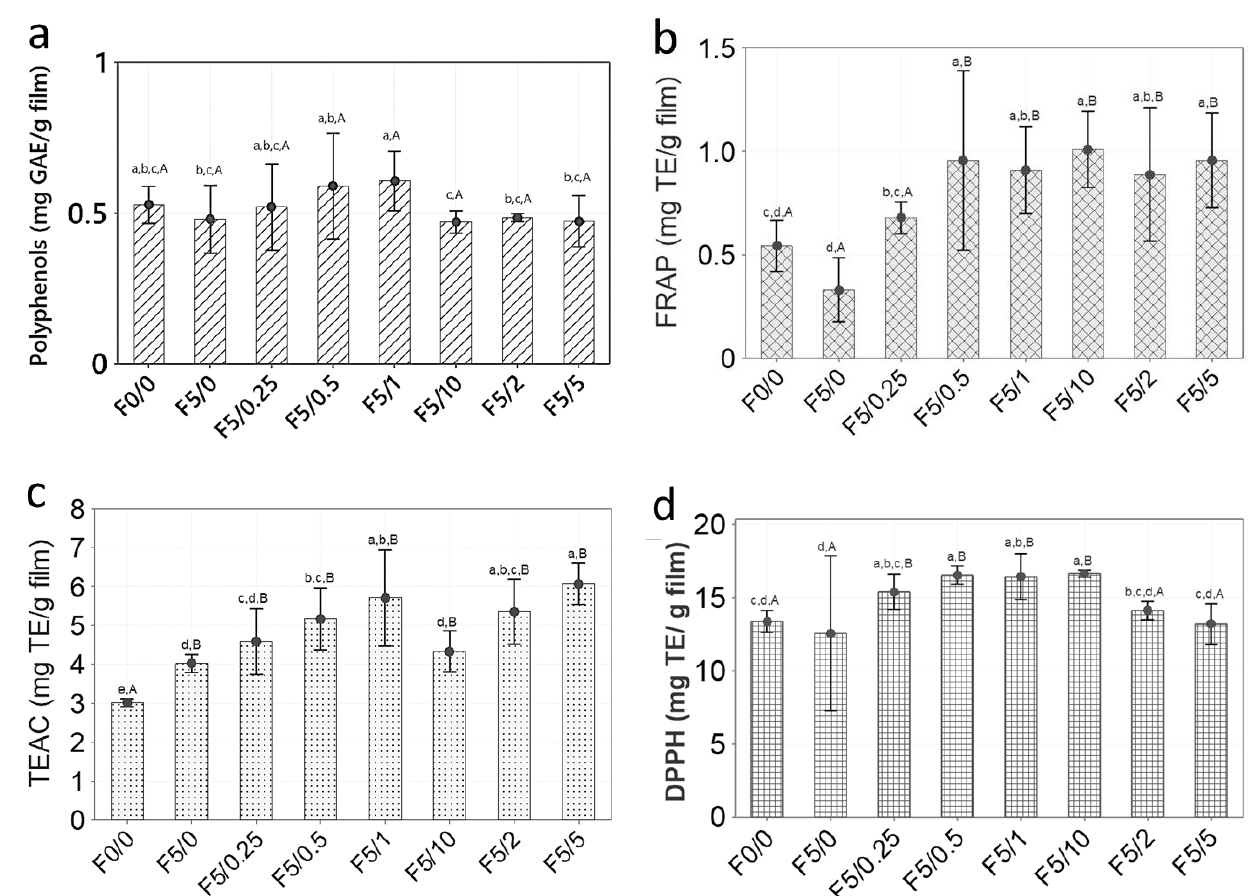
Figure 9. Antioxidant properties of CS-based films determined by TPC ( a ), FRAP ( b ), TEAC ( c ) and DPPH ( d ) assays. Different lowercase (a, b, c, d) or uppercase (A, B) letters within a column indicate significant differences between samples by Tukey’s test or Dunnett’s test, respectively ( p < 0.05). The results of TPC were calculated using a linear regression (Equation (1)) that used a The FRAP of the CS-based films was determined using a standard curve of Trolox, standard gallic acid curve, expressed as mg of gallic acid equivalent (GAE) per g − 1 of film. calculated using a linear regression (Equation (3)) and expressed as mg of Trolox equiva- lent per g of sample. Absorbance sample − TPC =